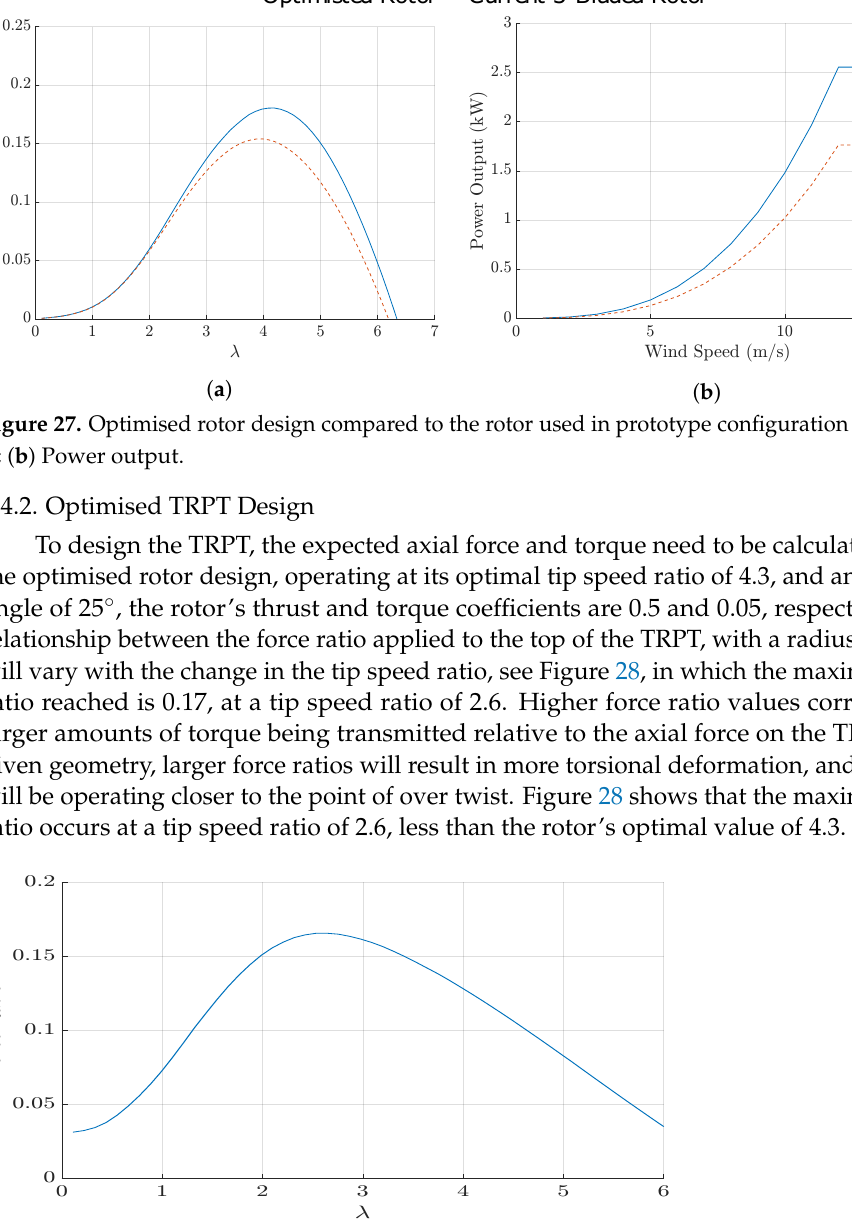
Figure 28. Force ratio against the tip speed ratio for the optimised Daisy Kite